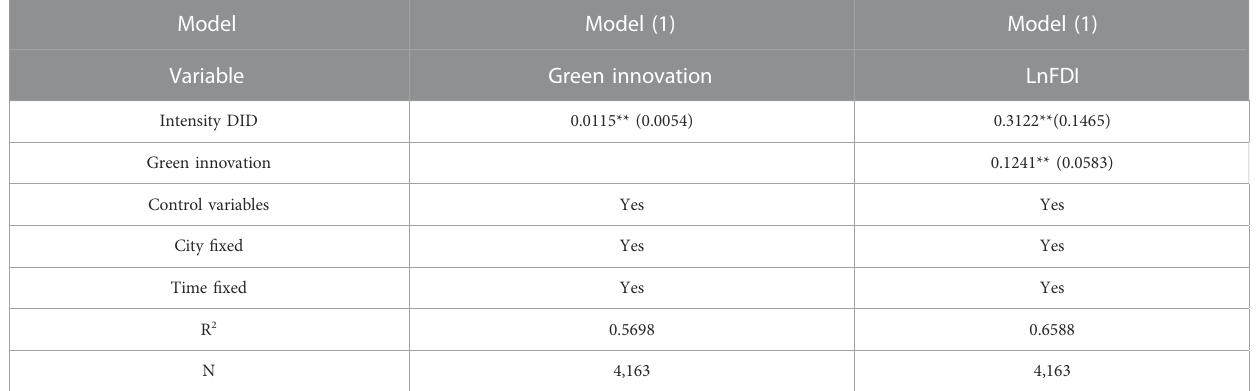
TABLE 4 Mechanism